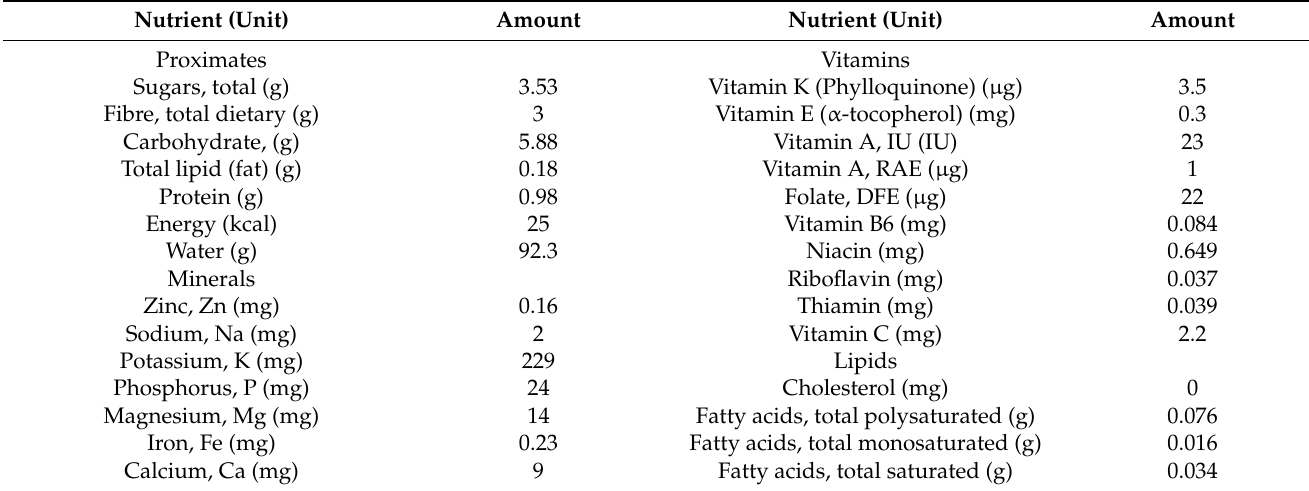
Table 2. Nutritional value of eggplant per 100 g (USDA report